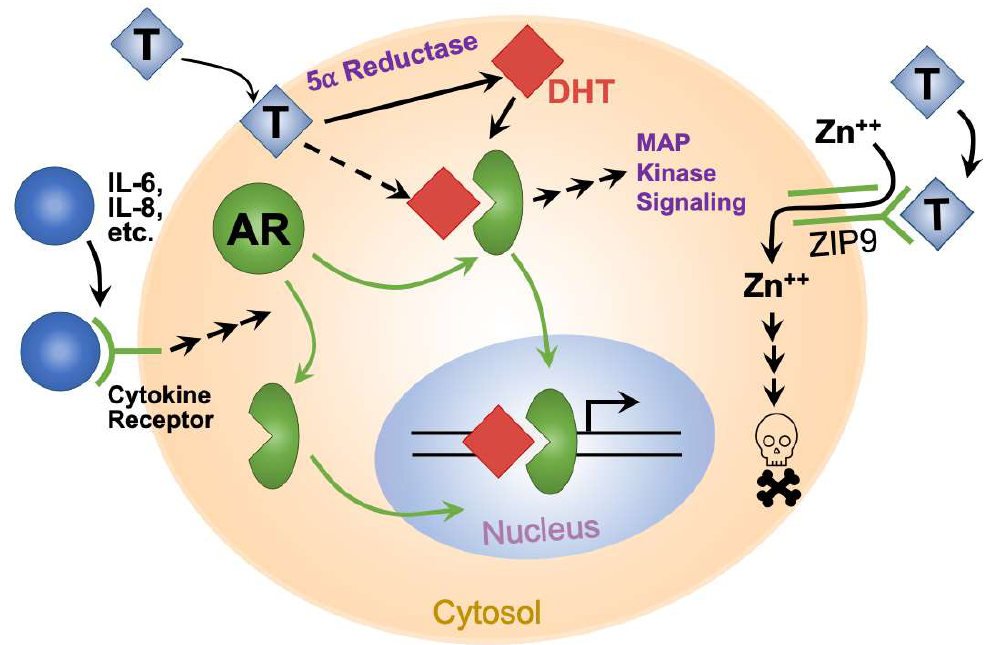
Figure 1. Schematic representation of androgen and AR signaling mechanisms in cells.